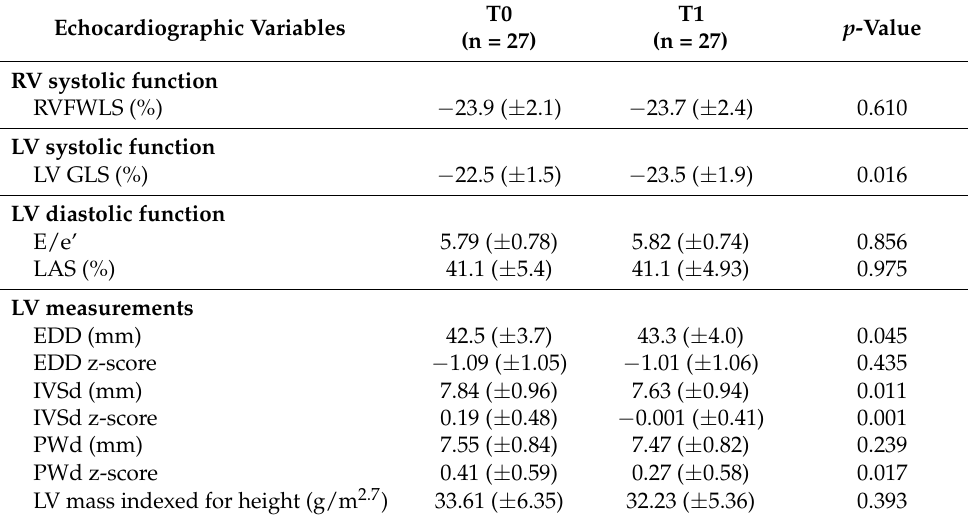
Table 3. Comparison between the echocardiographic data at baseline (T0) and after training (T1). Data are expressed as the mean ( ± standard deviation, SD). Z-scores are expressed as the mean ( ± SD). Echocardiographic Variables